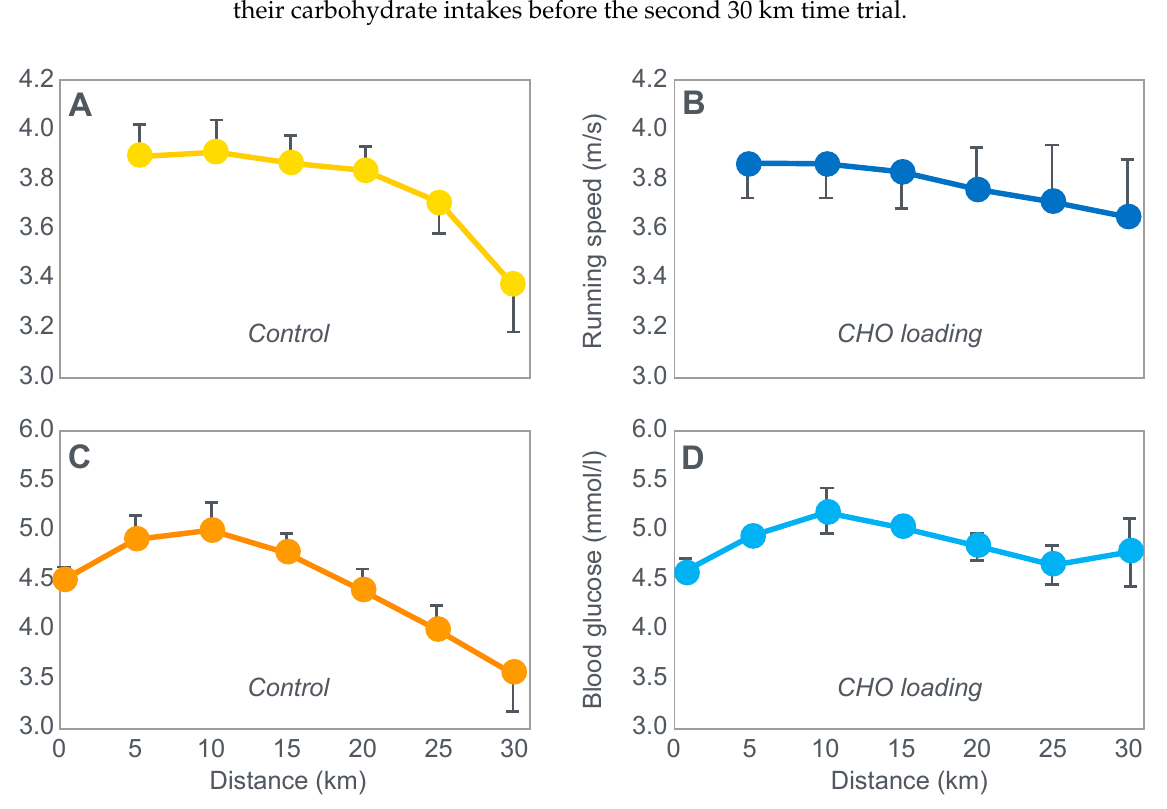
Figure 22. Changes in running speeds (panels A , B ) and in blood glucose concentrations (panels C , D ) in subjects running a 30 km time trial before (panels A , C ) and after (panels B , D ) 7 days of ‘carbohydrate loading’. ‘Carbohydrate loading’ prevented the development of hypoglycemia during the final 10 km of the race (panel D ) and was associated with better maintenance of running speed (panel B ). Adapted with permission from ref. [72]. Copy-right 1992 Springer Nature (European Journal of Applied Physiology).